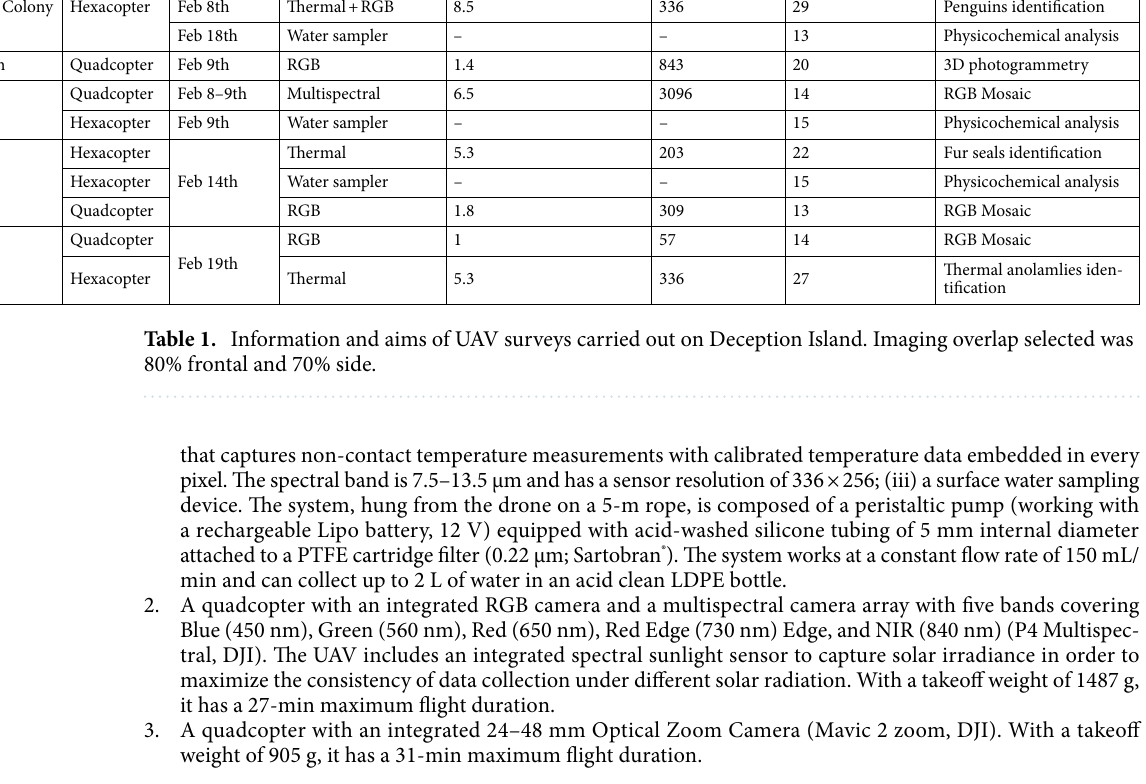
Ground sample distance (cm/pixel) No. of captures Flight time (min)